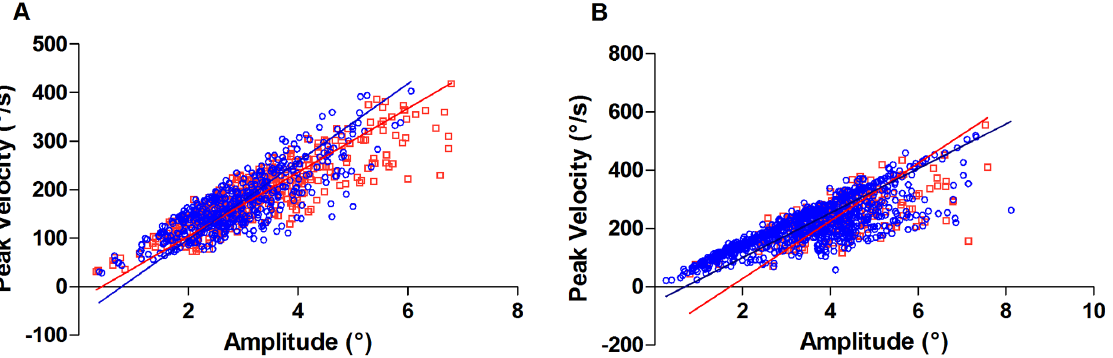
Figure 3. The SWI peak velocity–saccade amplitude relationship (the main sequence) of saccadic intrusions. Data were obtained with TLS regression (see methods). Data points are saccadic intrusions of patients pre-therapy (open red rectangle) and post-therapy (open blue circle). The colored lines are fitted to the respective data. A: Patient (Pt)1. B: Patient (Pt)2. RMSE: Pre Pt1: 0.5873; Post Pt1: 0.5771; Pre Pt2 : 0.8565; Post Pt2: 0.7689. Slope: Pre Pt1: 65.88; Post Pt1: 80.22; Pre Pt2: 99.05; Post Pt2: 76.46. Y-intercept: Pre Pt1: 2 27.96; Post Pt1: 2 63.07; Pre Pt2: 2 170.5; Post Pt2: 2 53.06.